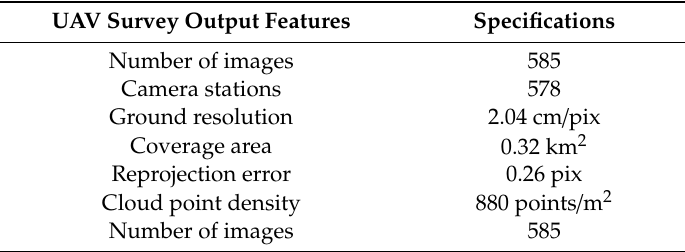
Table 4. Technical results for the Agisoft PhotoScan imagery